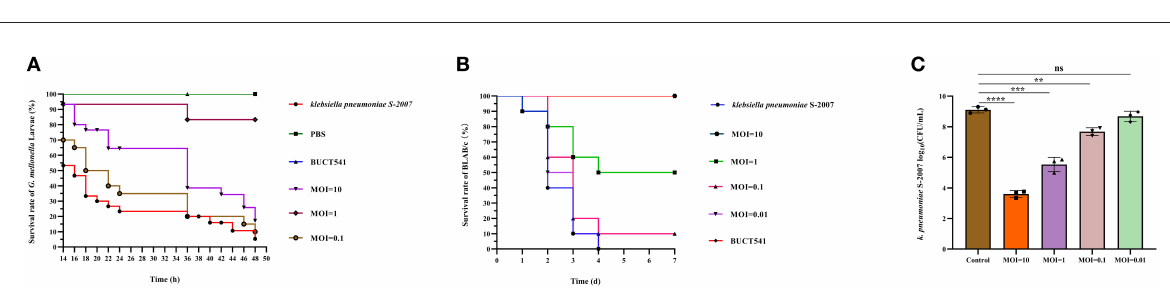
pYD38-A (GenBank: JF974312.1) and Aeromonas phage